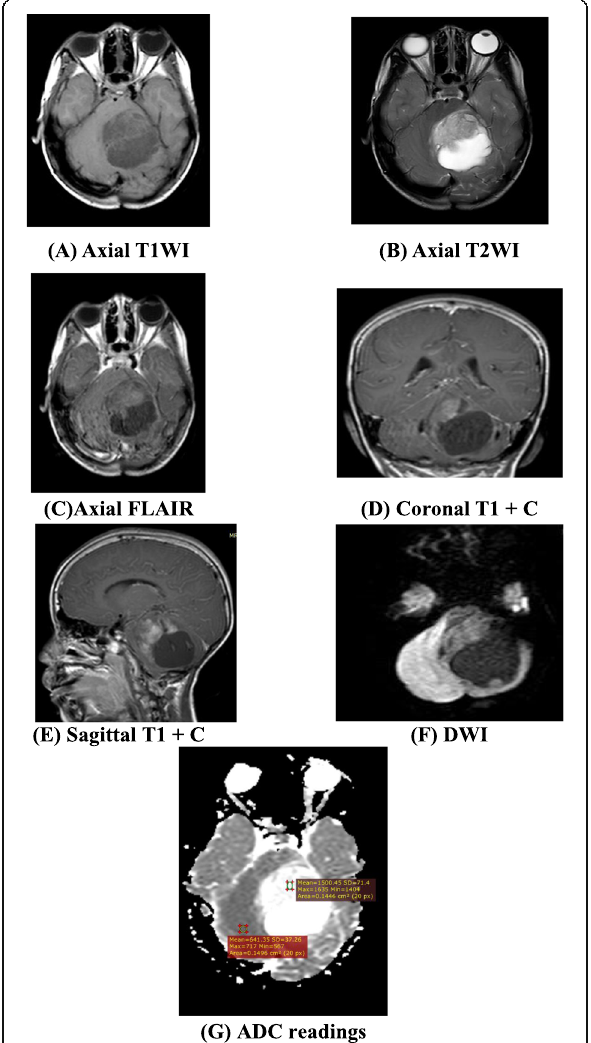
Fig. 3 A 6-year-old female patient complaining of headache. Axial T1 ( a ), axial T2 ( b ), axial FLAIR ( c ), coronal T1 post-contrast ( d ), sagittal T1 post-contrast ( e ) — a mixed cystic and solid SOL seen at posterior fossa involving cerebellar vermis and left cerebellar hemisphere measured 55 × 58 × 53 mm at its AP, width, and CC dimensions exerting mass effect inform of compressing 4th ventricle, the lesion mainly cystic displayed CSF signal intensity, solid nodule displayed low signal intensity at T1WI ( a ), high signal intensity at T2 ( b ), and FLAIR sequence ( c ) with mild contrast uptake ( d ), ( e ) seen only in the solid mural component. Axial DWI ( f ), axial ADC map ( g ) — the lesion showed free diffusion, ADC value of the lesion (1.490, 1.500, 1.570) × 10 − 3 mm 2 /s, average (1.500 × 10 − 3 ), ADC value of the normal cerebellum — (0.742, 0.743, 0.749) × 10 − 3 mm 2 /s, average 0.743 × 10 − 3 mm2/s, ADC ratio — 2.3 that are consistent with cerebellar pilocytic astrocytoma confirmed by histopathology